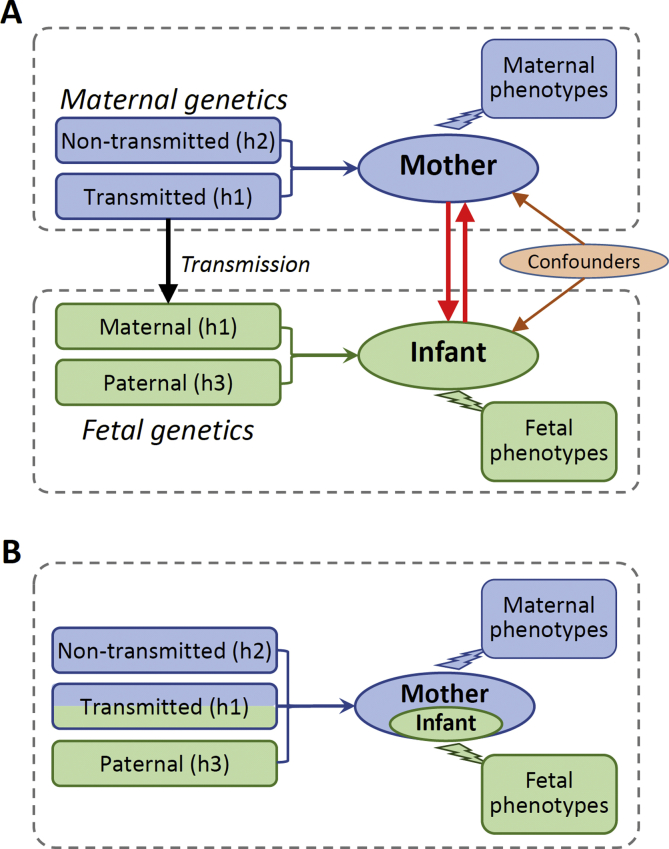
Conventional (A) and integrated maternal/fetal approach (B) to gestational phenotypes.